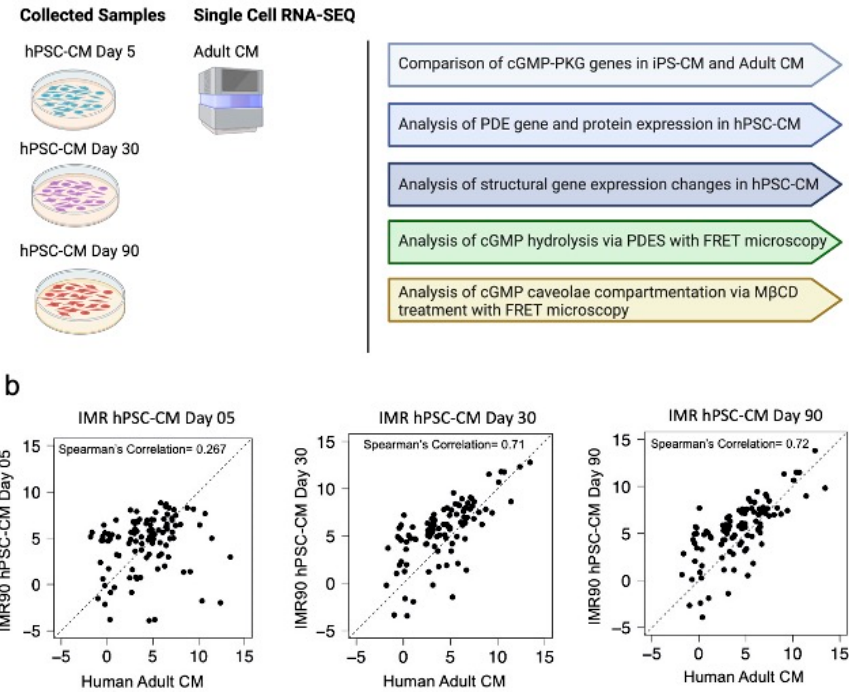
Figure 1. ( a ) Schematic of the executed experiments for the study. ( b ) Spearman’s correlation in fold changes of cGMP-PKG pathway gene expression in IMR-hPSC-CMs cultured for 5, 30, and 90 days as compared to adult